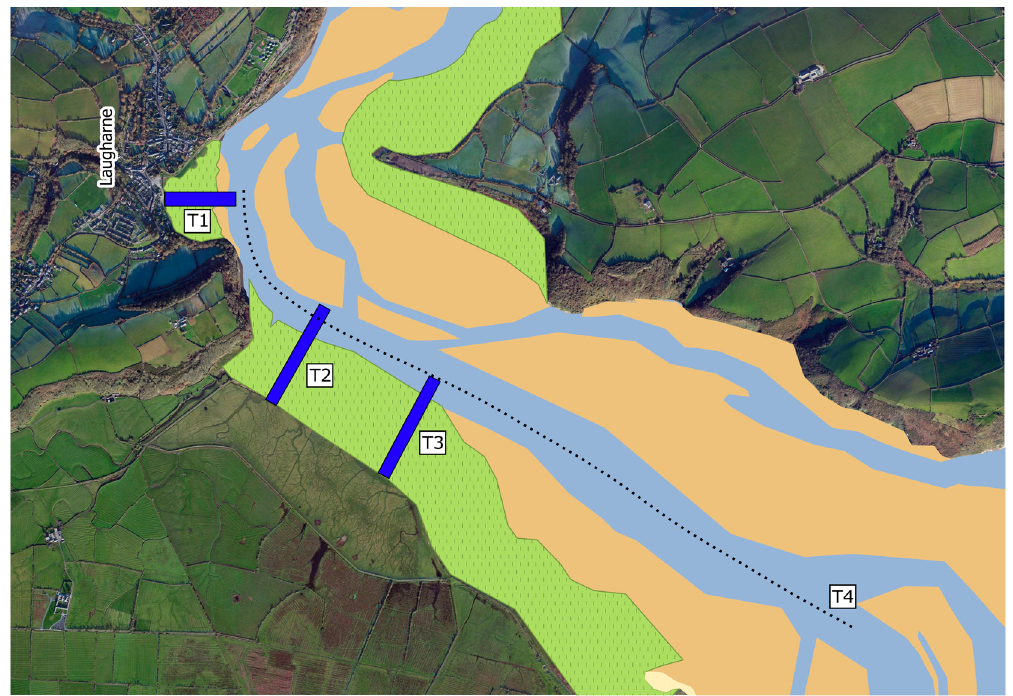
Figure 11. Transects and point locations selected for detailed hydrodynamic analysis. T1–4 and P1–4 represent the locations of transects 1–4, respectively.